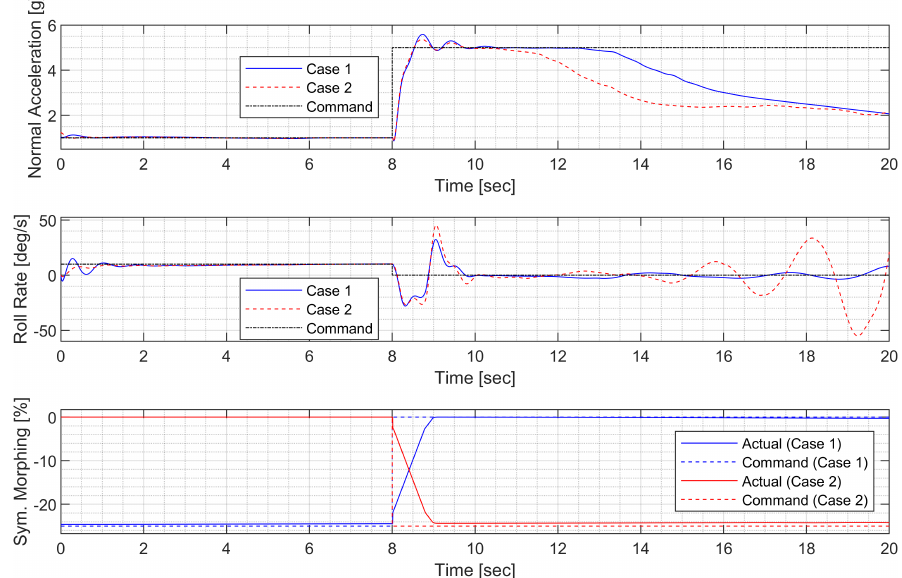
Figure 15. Controlled states and symmetric morphing parameter history for the high-g turn